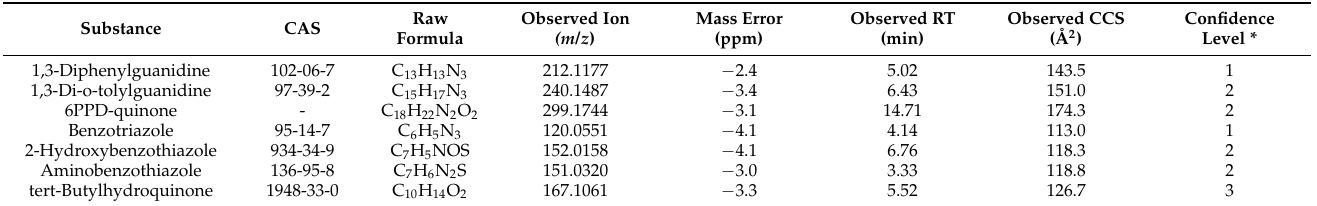
Table 8. Organic micropollutants potentially detected by HRMS suspect screening in ESI+